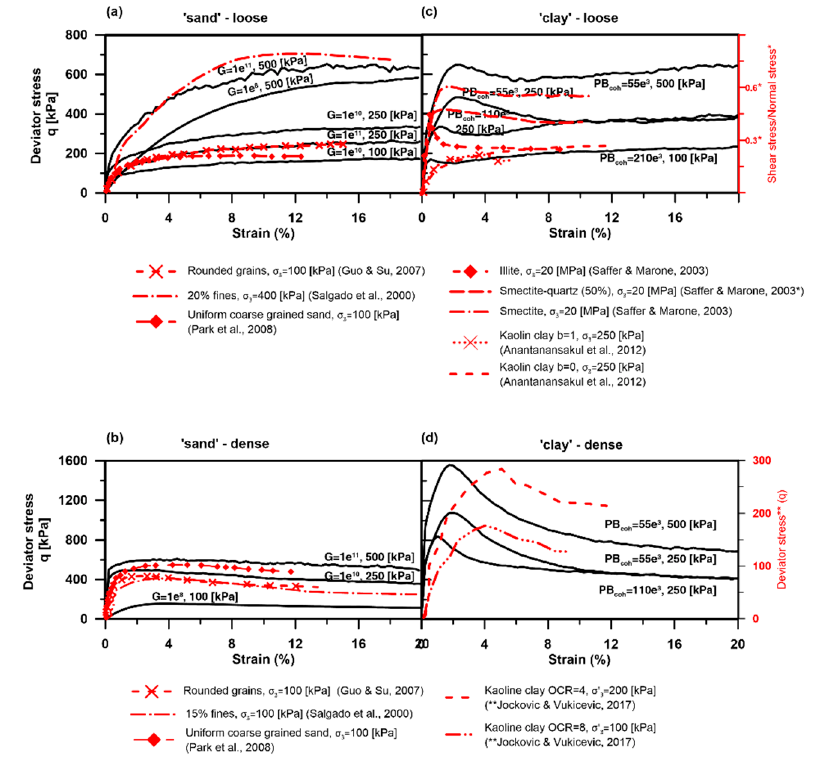
Figure 7. A comparison between the mechanical behavior (stress–strain) of the numerical results and laboratory experiments of sediments. Laboratory experiments of loose and dense sands and normally consolidated and overconsolidated clays are respectively compared to the numerical results. ( a ) loose ‘sand’ ( b ) dense ‘sand’ ( c ) loose ‘clay’ ( d ) dense ‘clay’. Solid black lines are results from the DEM simulations, found to resemble empirical lab results. Above each line, the micro-parameter size and confining stress are detailed. Dashed and dotted red lines are results of empirical triaxial tests on natural sediments. Data from Guo and Su [3] were recalculated to fit the deviatoric stress axis. For other data ([65,66]), the original y-axis is present on the right-hand side (red labels).